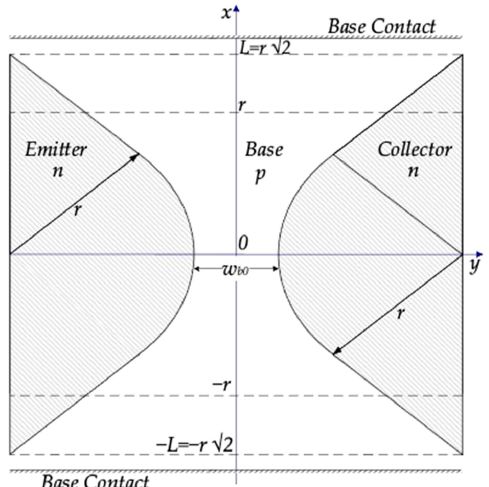
Figure 3. The geometry of the VES-BJT device.